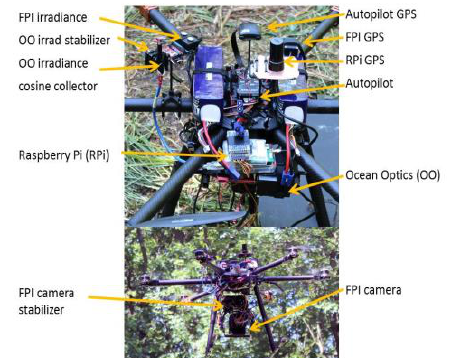
Figure 1. The instrumentation used in the UAV measurements